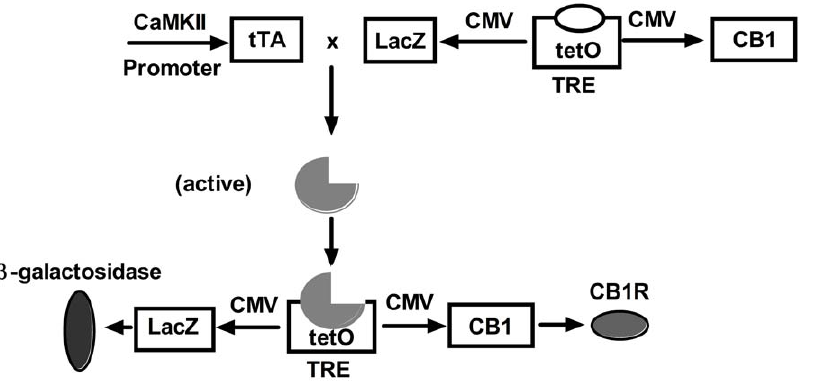
Figure 1. Schematic representation of the construct for generating the IR-CB1-/-. Tetracycline-controlled transactivator (tTA) expression was driven by the CaMKII promoter. In its active form, tTA binds to the tetO operator sequence that controls two promoters in opposite direction and initiates expression of the CB1 and Lac Z transgenes. Expression can be inhibited by Dox as it binds to tTA, making it inactive.